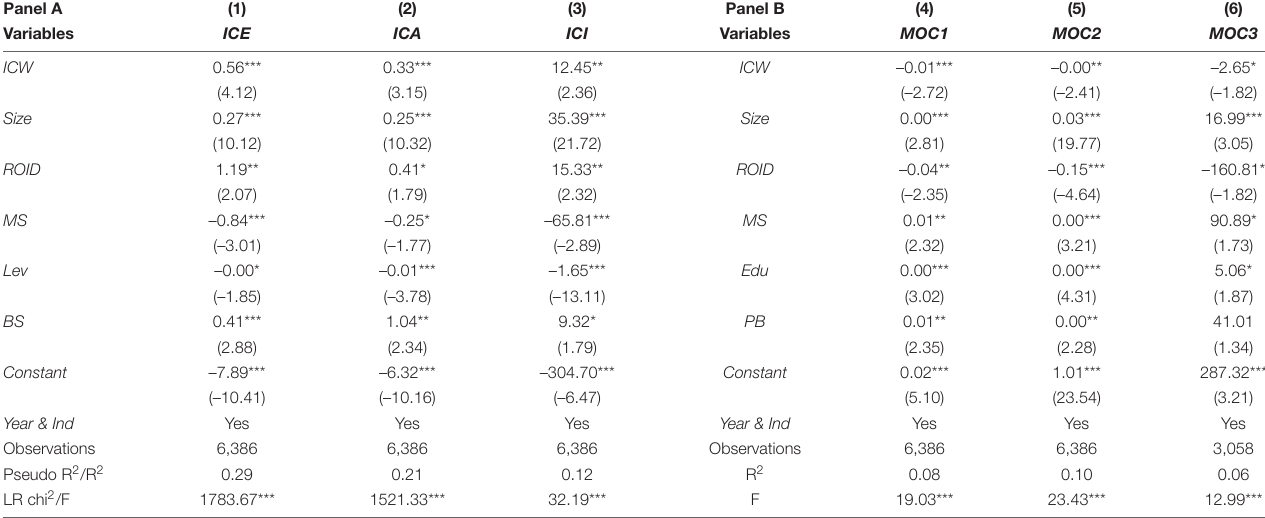
TABLE 3 | Regression